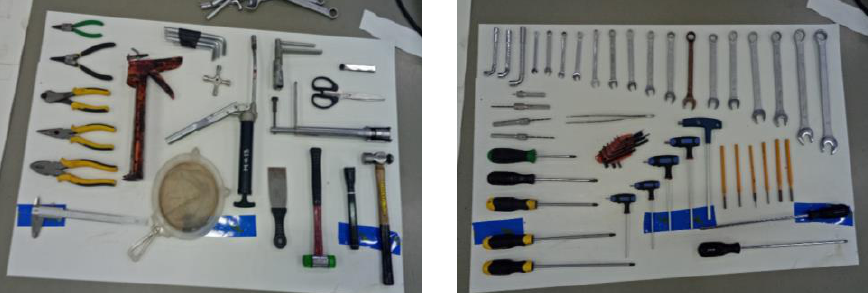
Fig. 2. Shadow boarding of 1 st drawer (frequently required item) and 2 nd drawer (not frequently required item).